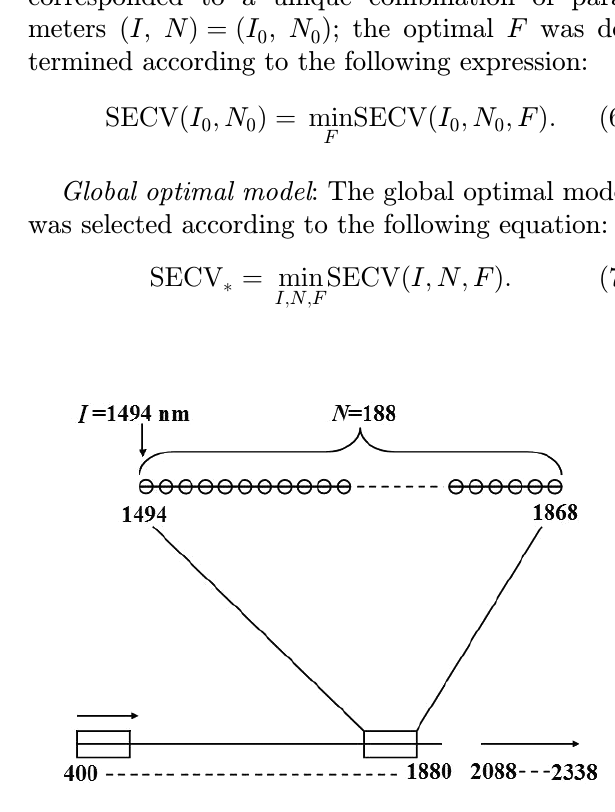
Fig. 5. Schematic for the waveband and screening mode for